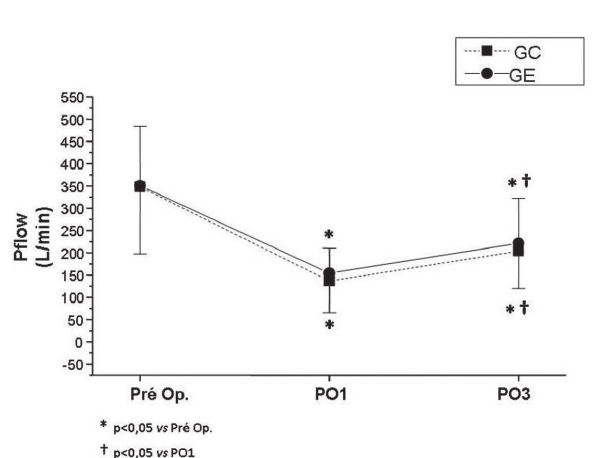
Fig. 5 - Evolução do pico de fluxo expiratório dos grupos estudados GC = grupo controle, GE = grupo estudo, peak flow = pico de fluxo